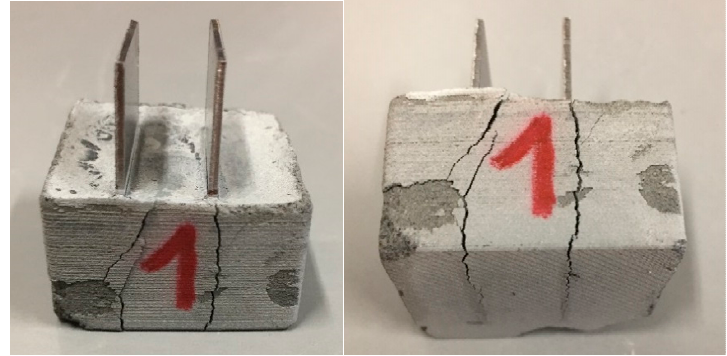
Figure 4. Photographs of specimen K1 with cracks propagating along the metal connector surfaces.